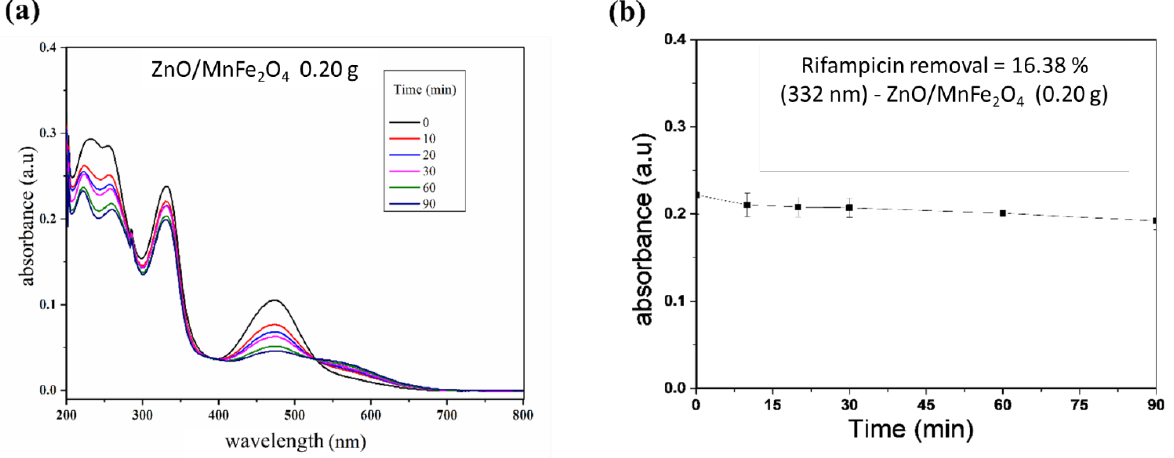
Figure 7. Control reaction in the dark. ( a ) Spectrum of rifampicin during reaction; ( b ) Removal curve of rifampicin.